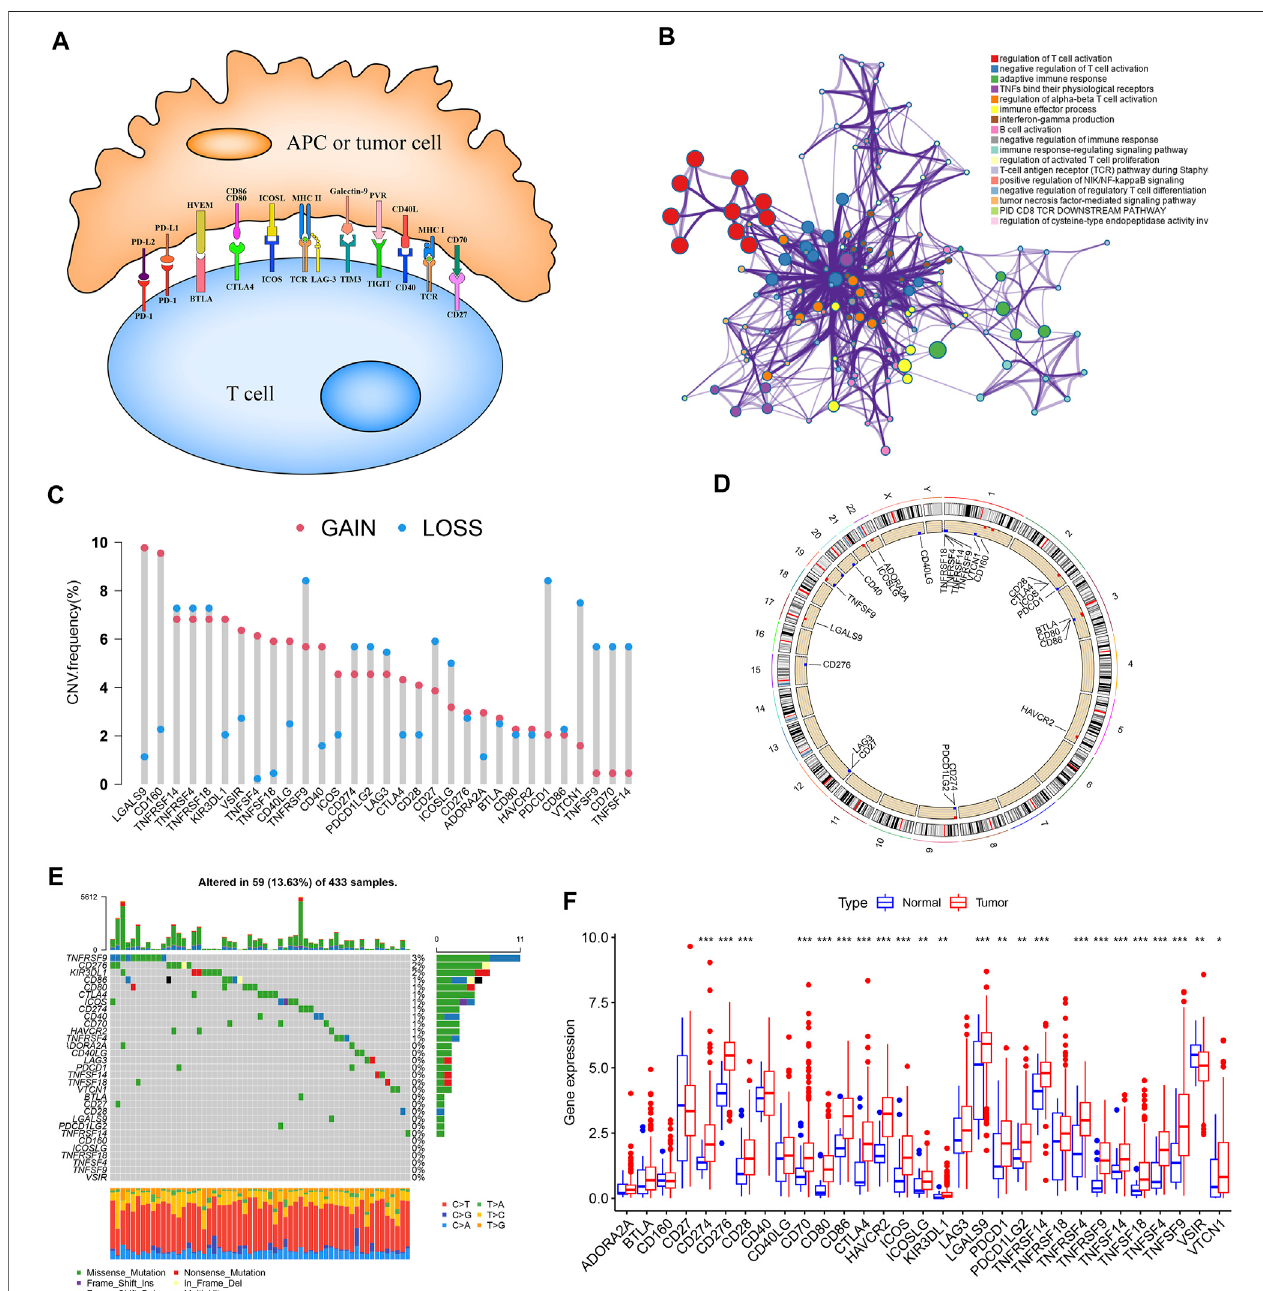
FIGURE 1| Landscape ofgenetic and expression variation ofICGsin GC. (A) Interaction of several speci fi c immune checkpoint molecules. (B) Potential biological function enrichment of 31 ICGs. (C) The CNV variation frequency of ICGs in TCGA-STAD cohort. (D) The location of CNV alteration of ICGs on 23 chromosomes in TCGA-STAD cohort. (E) The mutation frequency of 31 ICGs in GC patients from TCGA-STAD cohort. (F) The expression of 31 ICGs between normal tissues and GC tissues. * p < 0.05, ** p < 0.01, *** p < 0.001.